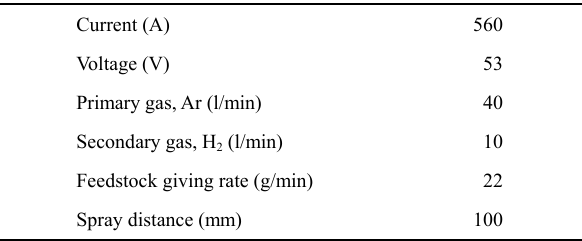
Table 1 Plasma spray parameters for the preparation